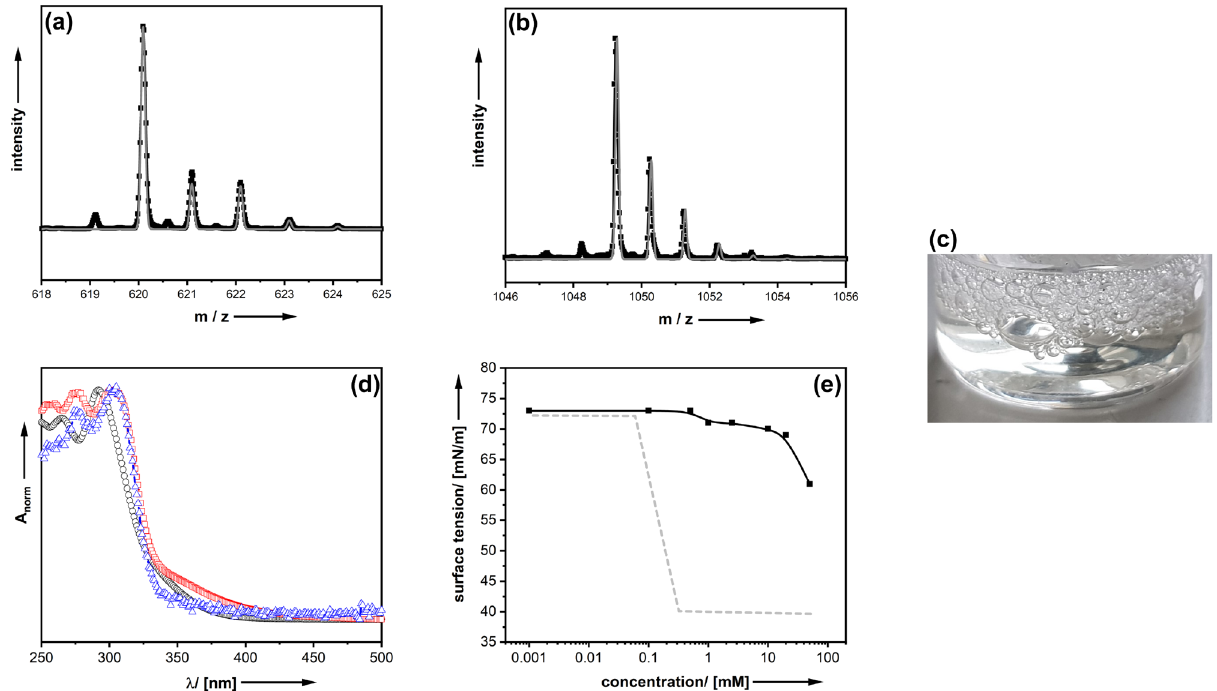
Figure 2. Characterization and hydrolytic stability tests of representative M-DO3A-C 4 -SO 3 compounds dissolved in aqueous solution at neutral and alkaline pH values. ( a ) ESI–MS pattern of Ce-DO3A-C 4 -SO 3 (black = measurement; grey = simulation for M = [Ce-DO3A-C 4 -SO 3 H]H + . ( b ) ESI–MS pattern of Sc-DO3A- C 4 -SO 3 (black = measurement; grey = simulation for M = [Sc-DO3A-C 4 -SO 3 ] 2 . ( c ) Photographic image of a solution of Ce-DO3A-C 4 -SO 3 in water. ( d ) UV–VIS spectra (absorption normalized) of Ce-DO3A-C 4 -SO 3 in water at pH = 7 (black circles), pH = 12 (red squares) and pH = 12; t = 48 h (blue triangles). ( e ) concentration dependent surface tension for Ce-DO3A-C 4 -SO 3 ; black = experimental points, grey = idealized behavior for a surfactant as a